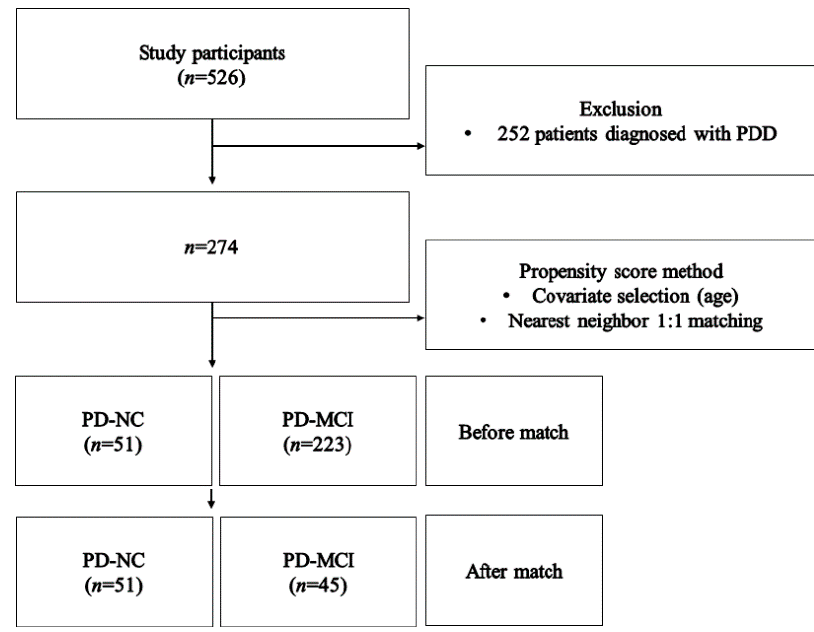
Figure 1. Framework of study.